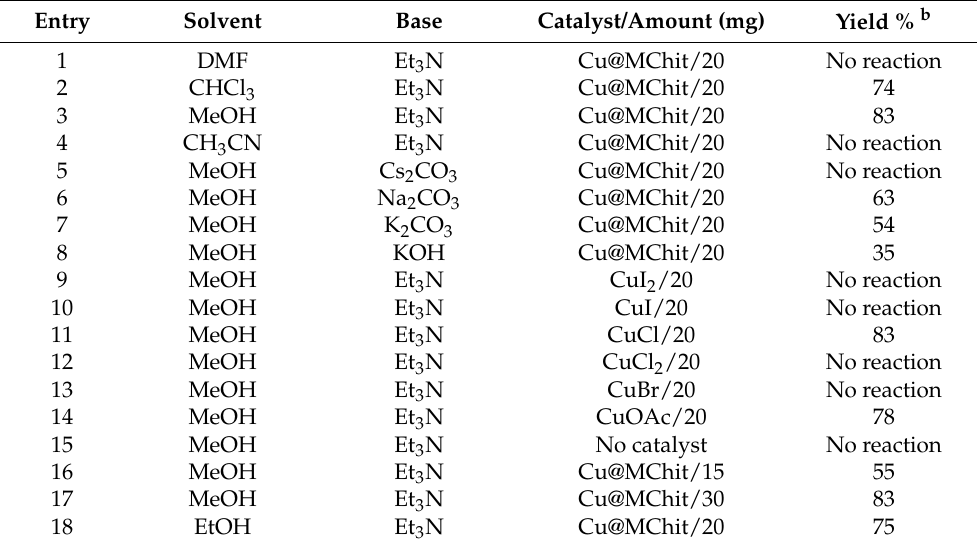
Table 1. Optimization conditions of the reaction a